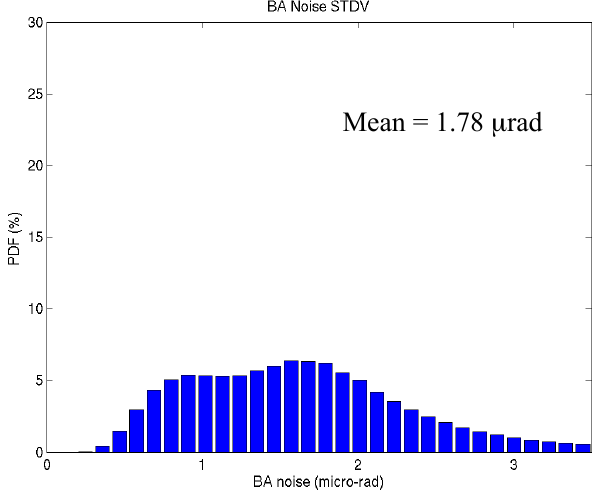
Fig. 13. Distribution of standard deviation of bending angle noise for each occultation between 60 and 80km heights for ∼ 308000 F3C profiles from July–December 2009.